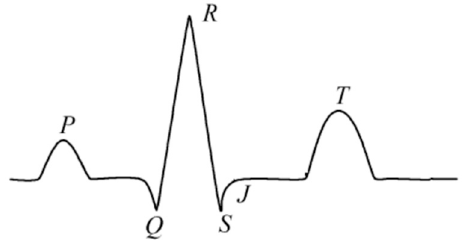
Figure 1. Wave form of QRS complex.